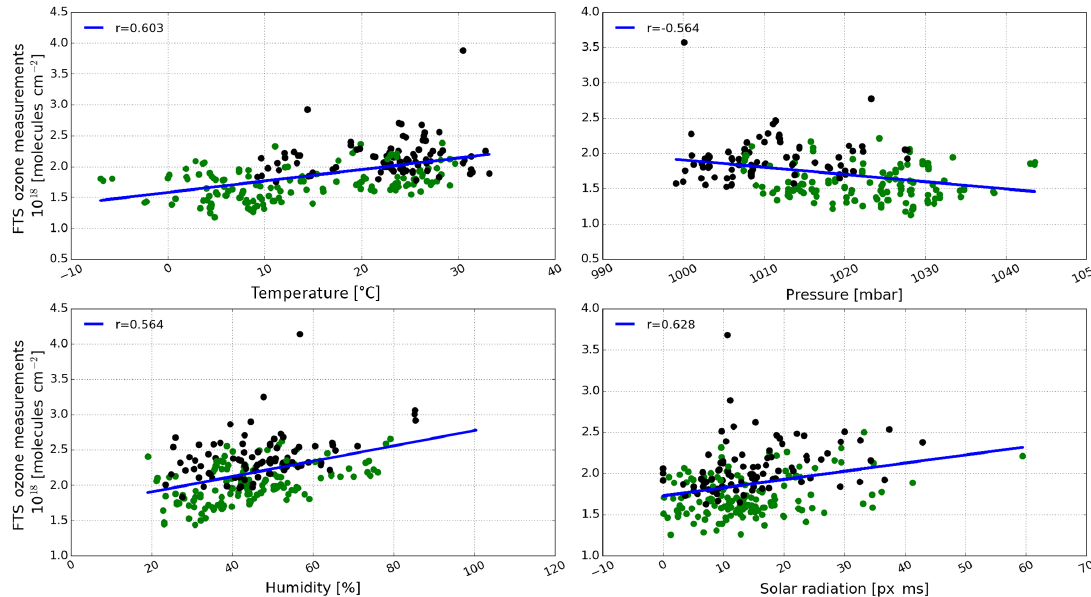
Figure 4. Correlation plot between the FTS tropospheric O 3 column and the coincident surface meteorological data. Black dots are data pairs within the MAM/JJA season and green dots are data pairs within the SON/DJF